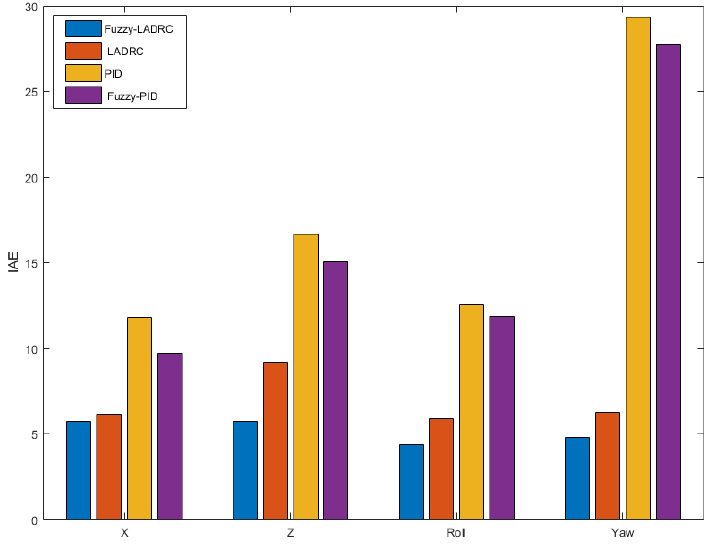
Figure 10. IAE for tracking triangle wave signal. According to (34), u ( t ) is the control signal of the controller. Taking X-channel tracking triangle wave signal as an example, u ( t ) of the four controls are shown in Figure 11. For comparison purposes, the area of the region formed by u ( t ) and the time-axis is calculated as the input energy. The input energies of the four controllers are shown in Figure